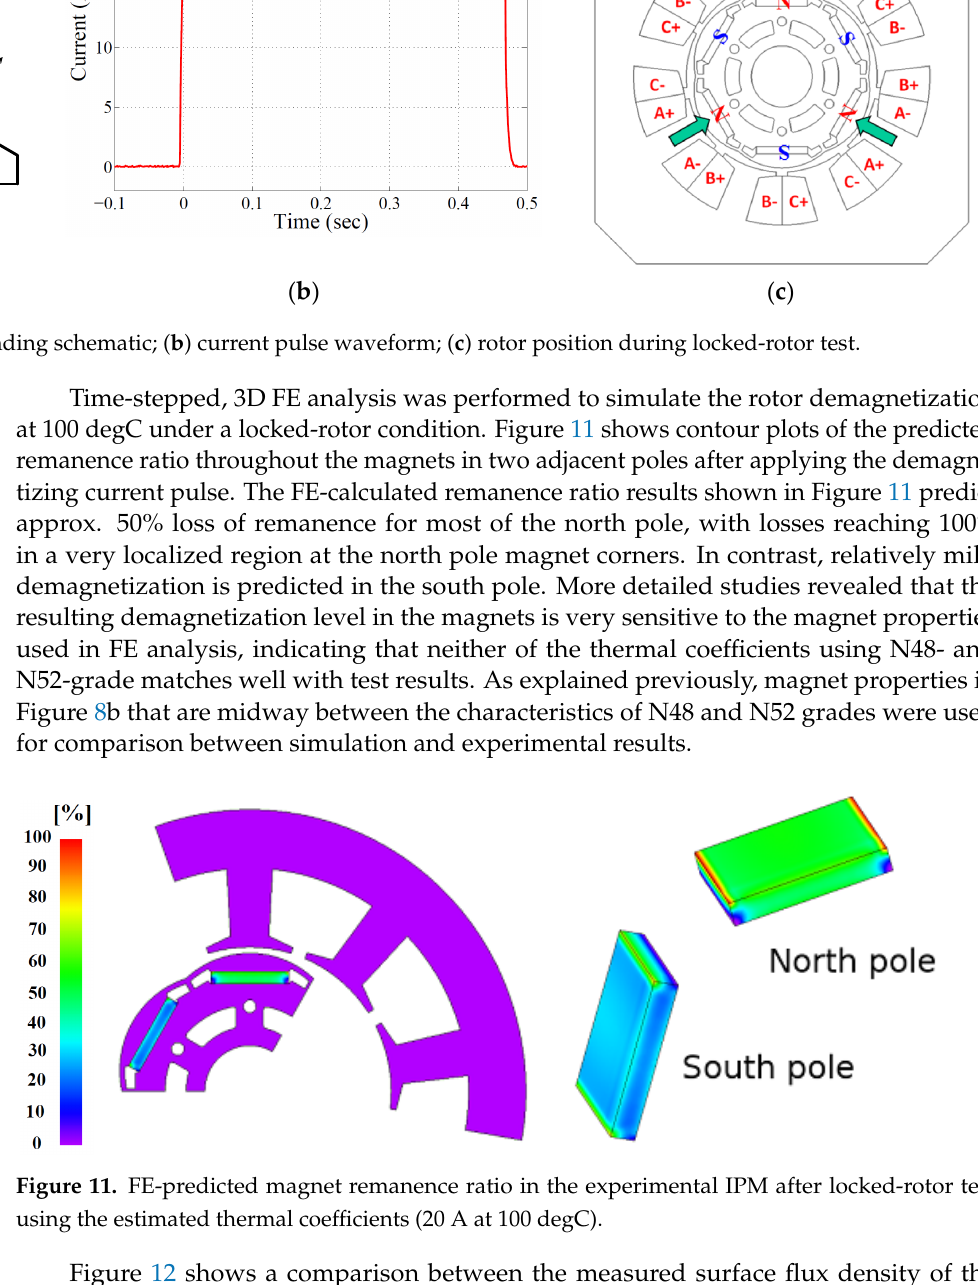
Figure 9. Dynamometer test configuration: ( a ) locked-rotor test setup; ( b ) heat gun with duckbill nozzles for temperature control.